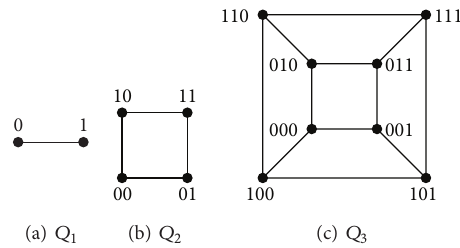
Figure 1: Hypercubes of small dimension.